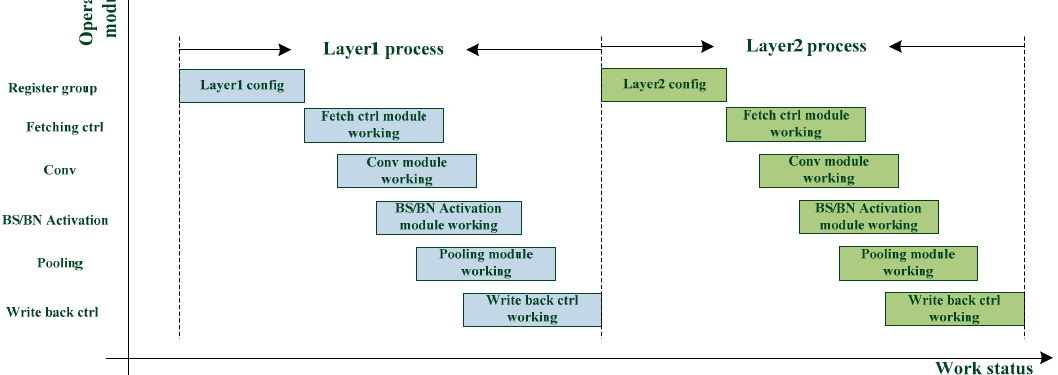
Figure 3. Processing of a classical CNN accelerator.